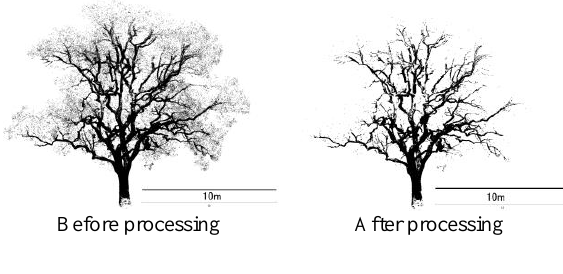
Figure 7. Noise processing using SOR and MLS